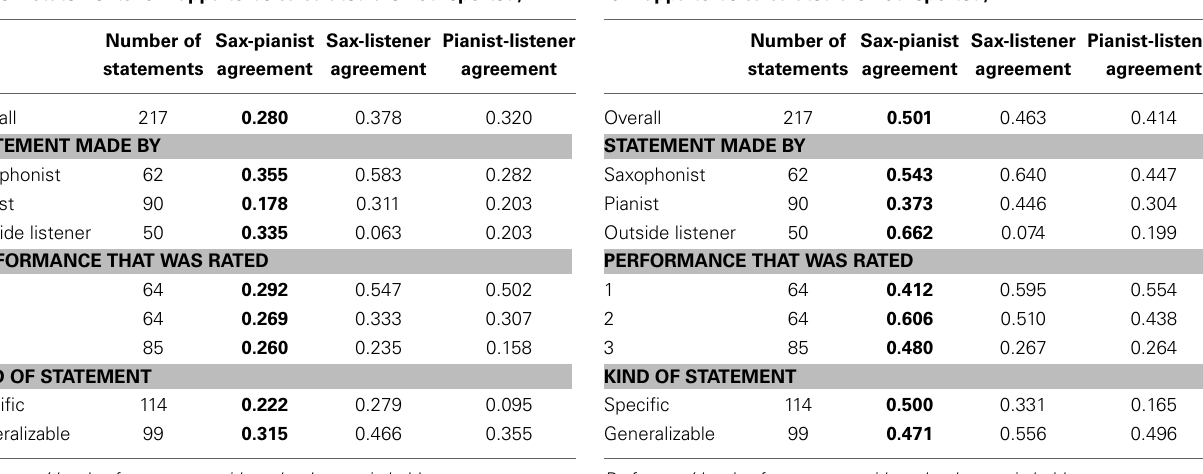
categories: both endorse, both neutral, both dissent (Categories with too few statements for kappa to be calculated are not